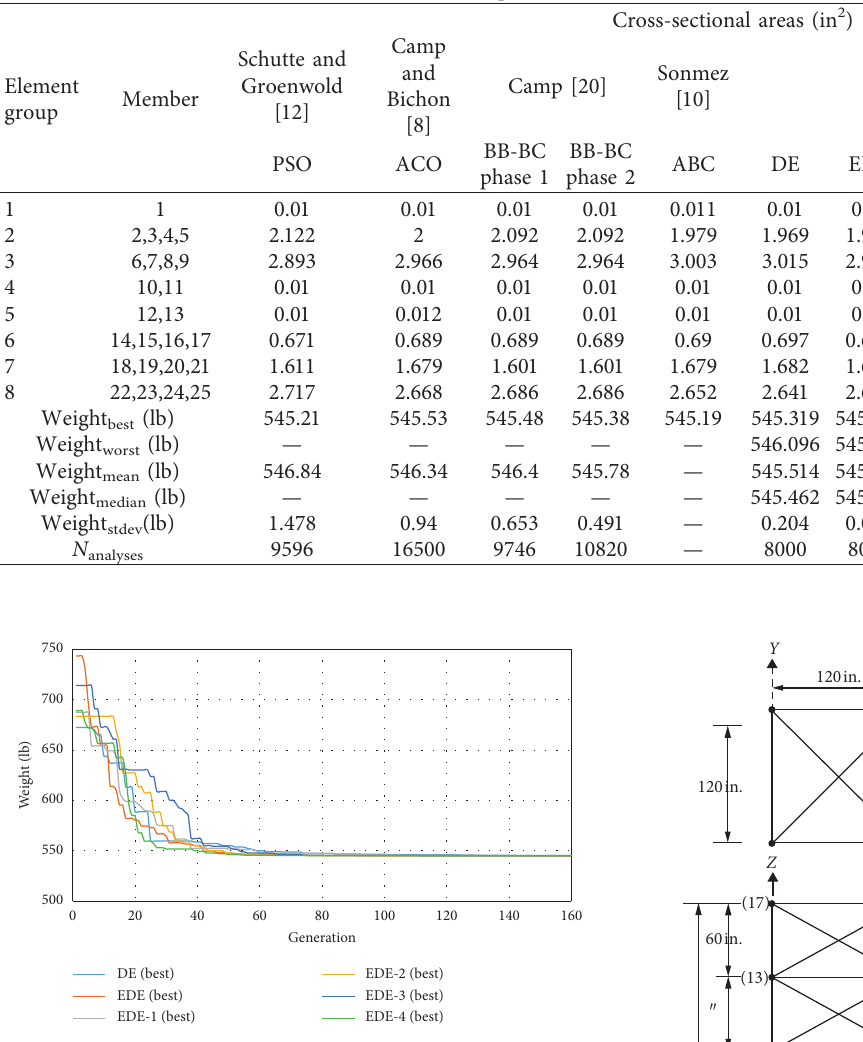
Table 4: Performance comparison for the 25-bar truss under the two load cases.